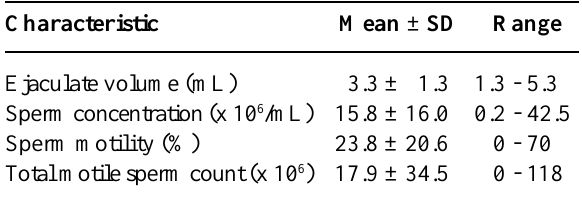
Table 2 – Seminal parameters before intervention.